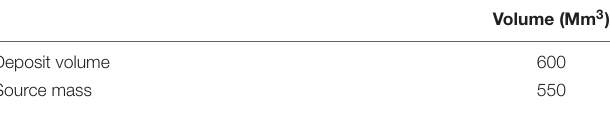
TABLE 3 | Calculated volumes of the source and deposition area of the rock avalanche of